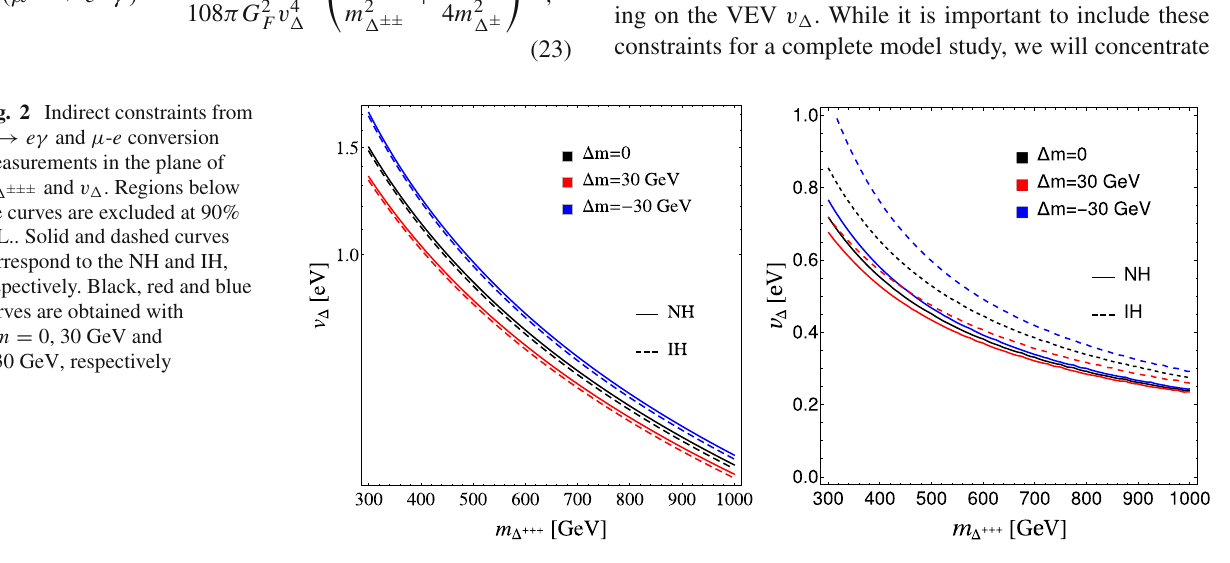
Fig. 2 Indirect constraints from μ → e γ and μ - e conversion measurements in the plane of m (cid:2) ±±± and v (cid:2) . Regions below the curves are excluded at 90% C.L.. Solid and dashed curves correspond to the NH and IH, respectively. Black, red and blue curves are obtained with (cid:2) m = 0, 30 GeV and − 30 GeV,